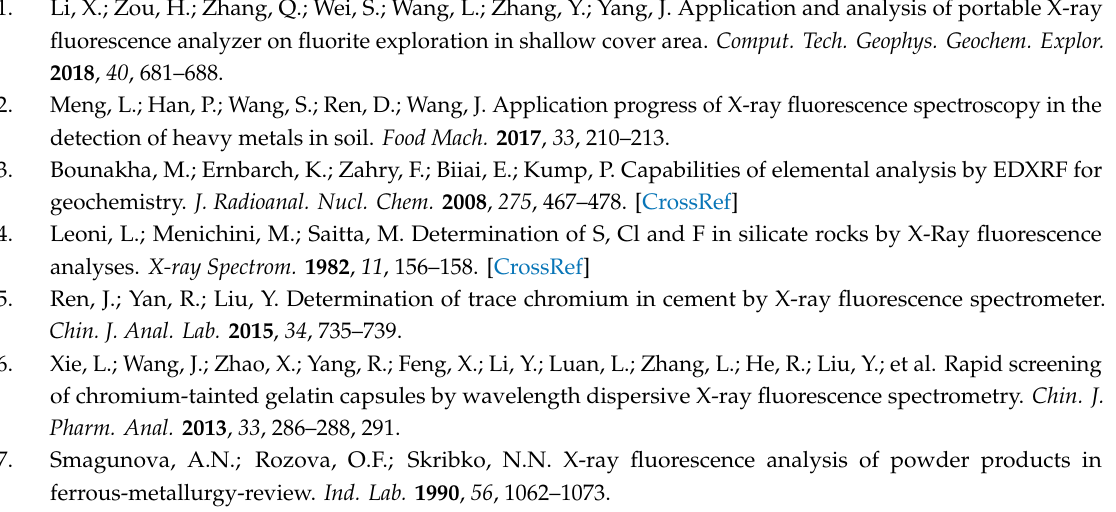
Figure S1: Fused glass disc preparation procedure, Figure S2: Procedures for mixing the samples and flux by (a) grinding, (b) stirring, and (c) shaking, Table S1: Details of the certified reference materials (CRMs), Table S2: Results of the major and minor element determination by X-ray fluorescence (XRF) analysis of the samples prepared by the three preparation procedures, Table S3: Source of recommend values of 19 CRMs, Table S4: The values of J S;i by grinding method, Table S5: The values of J S;i by stirring rod method, Table S6: The values of J S;i by shaker cup